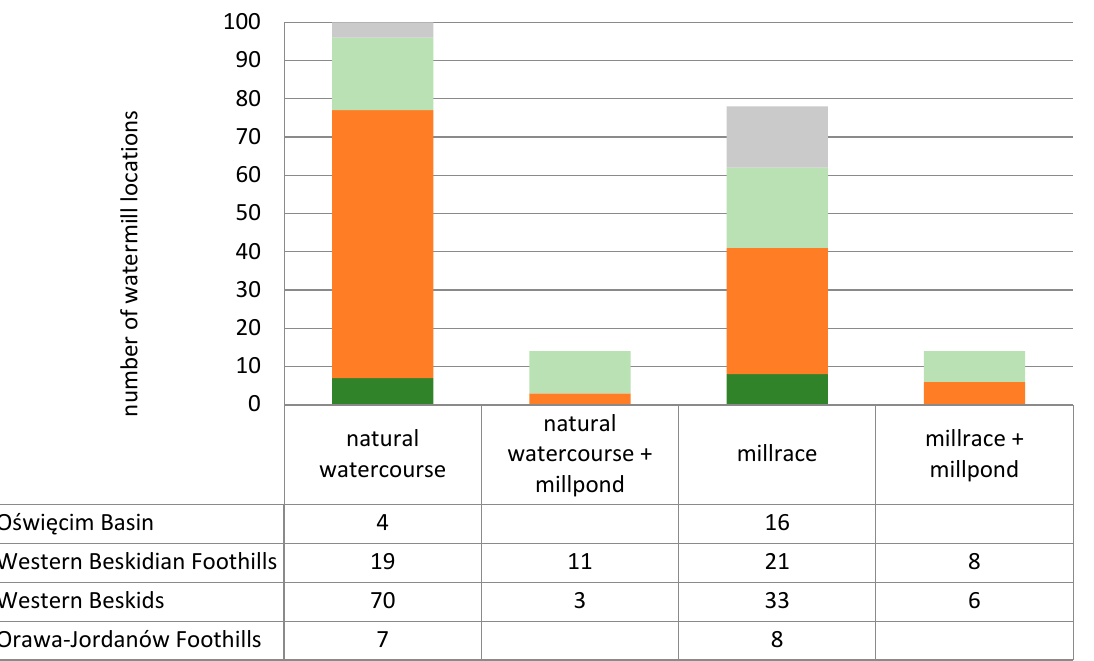
Figure 3. The continuity of operation of watermills in the River Skawa catchment in the period 1855–1930. Blue cells represent a period of uninterrupted work.